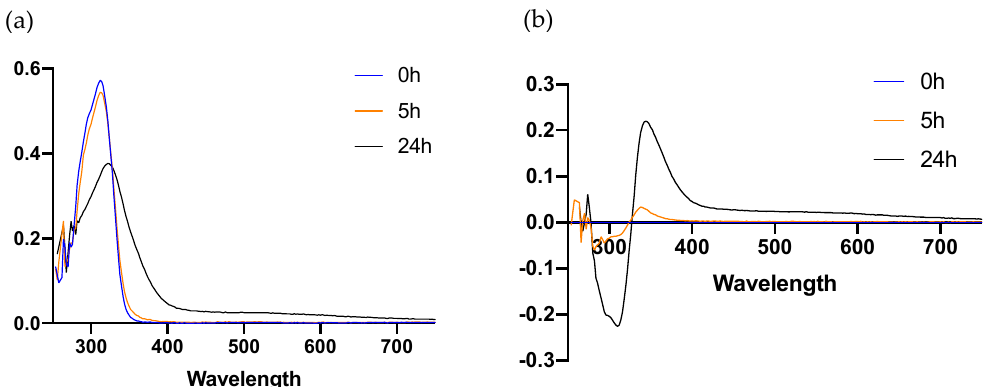
Figure 7. UV-VIS spectra of 5,6-dihydroxyindole-2-carboxylic acid (DHICA)-melanin solutions 24 h after blue light irradiation. Data show changes in the UV-VIS spectrum induced by blue light irradiation over 24 h (a) . Changes in differential spectrum relative to the 0 h control (b) . DHICA-melanin solutions UV-VIS spectra were measured before blue light exposure and 5 h and 24 h after irradiation (76 J/cm 2 ).